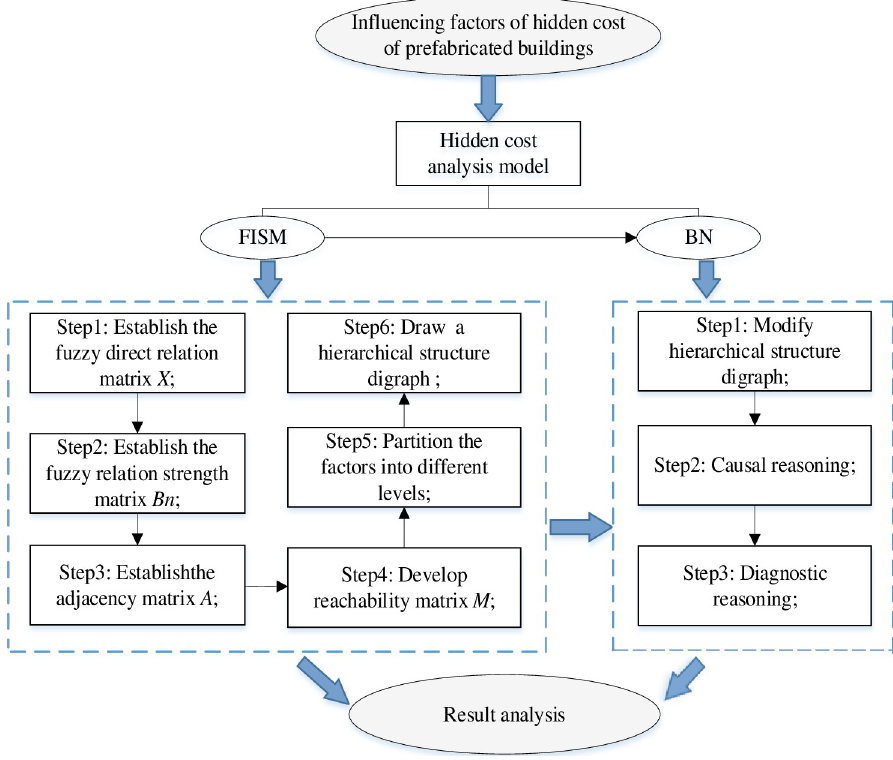
Fig 2. The process of FISM-BN hidden cost analysis